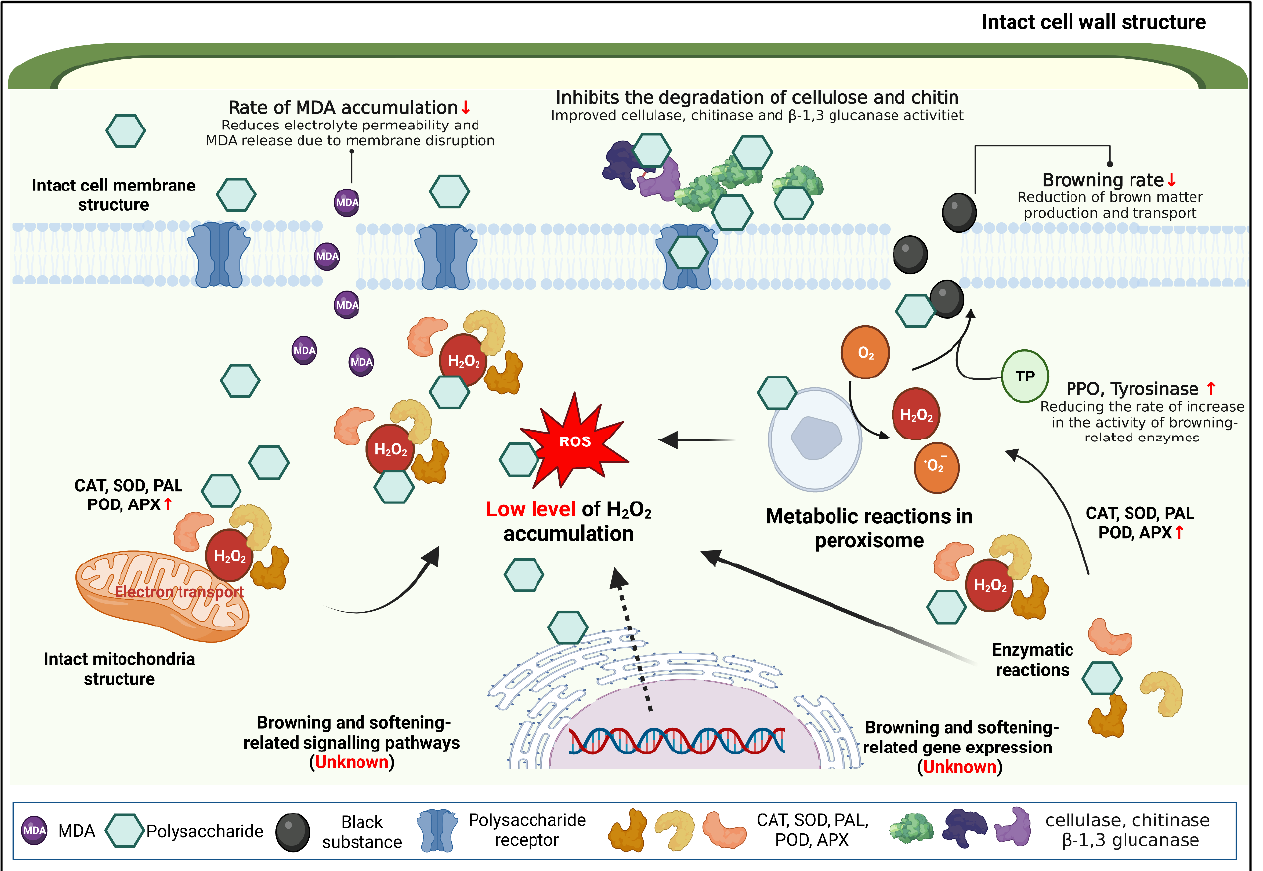
Figure 4. Mechanism of action of plant polysaccharides in the preservation of edible mushrooms. Created with BioRender.com.